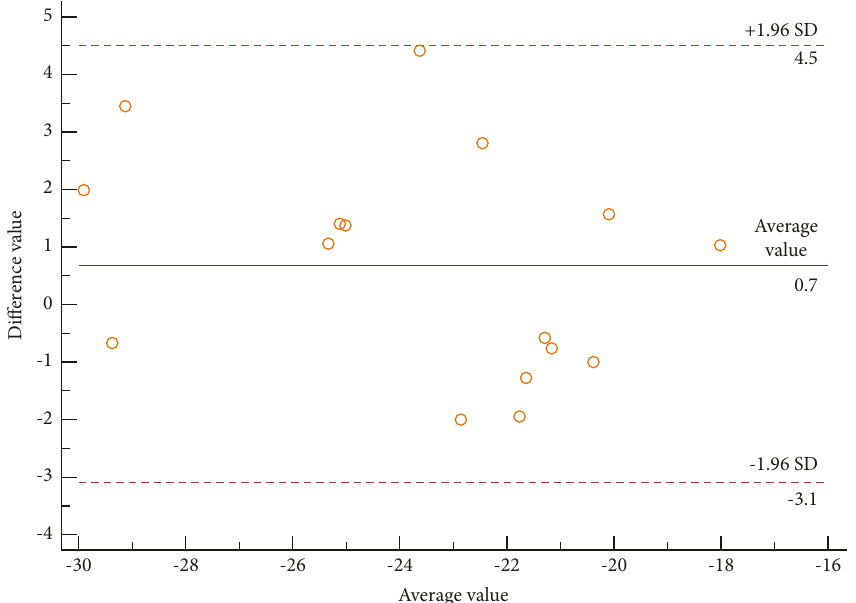
Figure 9: Analysis of the interobserver consistency of GLS.